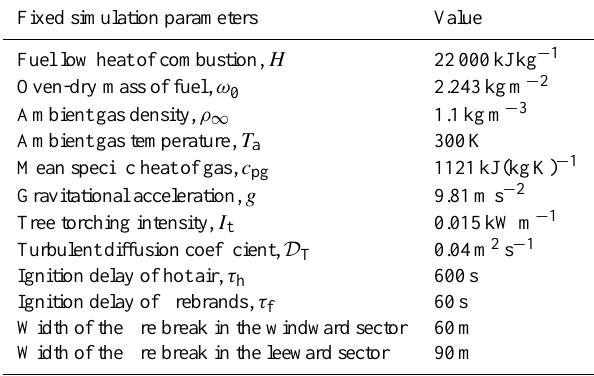
Table 1. Values of the parameters of the model which are kept fixed throughout the numerical simulation discussed here.